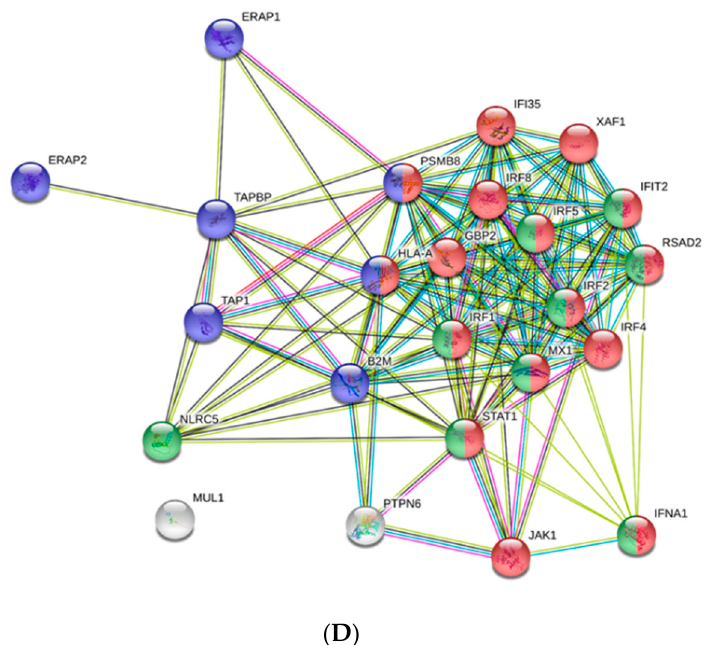
Figure 2. GO Immune System Process categories overrepresented in the transcriptomic analysis of PB-RBCs and head kidney HK-RBCs from VHSV-challenged rainbow trout. ( A ) Pathway enrichment network analysis under the GO Immune System Process database from PB-RBCs of VHSV-challenged rainbow trout. Pathway enrichment analysis was performed selecting GO Immune System Process terms with p -value < 0.05, GO Term fusion, and GO Tree interval of 3–8. Red indicates upregulated pathway. ( B ) The number of upregulated and downregulated genes in each represented GO Immune System Process category from VHSV-challenged rainbow trout PB-RBCs. Asterisks denote GO term significance. ( C ) Number of upregulated and downregulated genes in each overrepresented GO Immune System Process category from VHSV-challenged rainbow trout HK-RBCs with the following analysis parameters: p -value < 0.1, GO Term fusion, and GO Tree interval of 3–8. ( D ) Protein–protein interaction (PPI) networks of DEGs identified in the GO Immune System Process terms of HK-RBCs from VHSV-challenged rainbow trout constructed using STRING software ( p -value < 10 − 16 ). Nodes represent proteins, while edges denote the interactions between two proteins. Di ff erent line colors represent the types of evidence used in predicting the associations: Gene fusion (red), gene neighborhood (green), co-expression (black), gene co-occurrence (blue), experimentally determined (purple), from curated databases (teal), text-mining (yellow), or protein homology (lilac). Red nodes denote proteins implicated in the type I interferon signaling pathway (GO:0060337), blue nodes denote proteins implicated in antigen processing and presentation (GO:0019882), and green nodes denote proteins implicated in defense response to virus (GO:0051607).